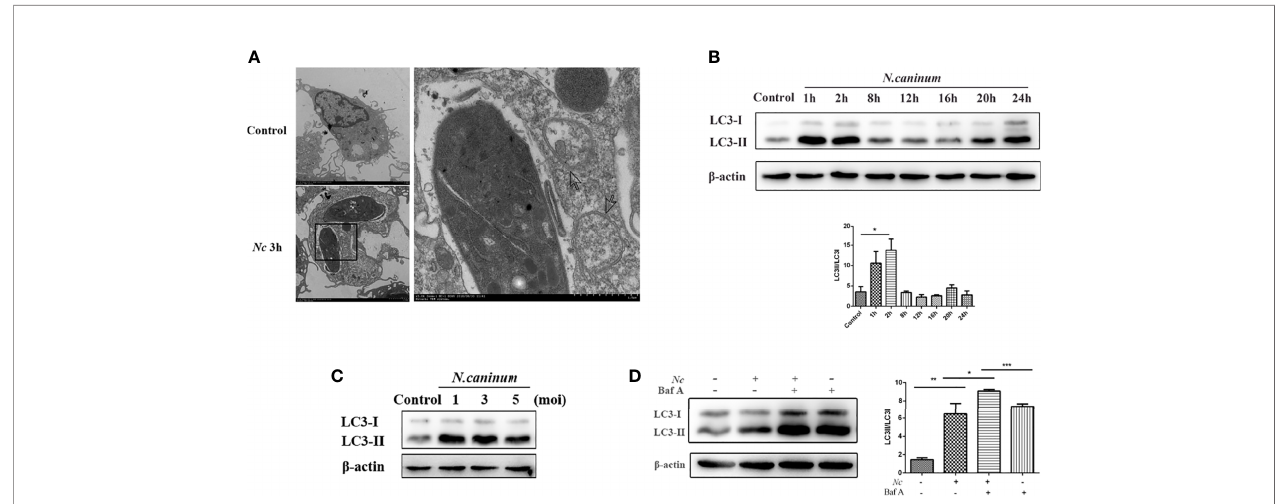
FIGURE 1 | Autophagosomes accumulate in Neospora caninum -infected macrophages. (A) Representative transmission electron microscopy images of the control and Nc -infected mouse macrophages at 3 h postinfection. Arrows indicate representative autophagosomes. (B) Peritoneal macrophages were infected with N. caninum tachyzoites (MOI = 3), and total protein was extracted after 0, 1, 2, 4, 8, 12, 16, 20, and 24 h. The expression of LC3 and the ratio of LC3-II to LC3-I were examined at the indicated times. (C) Infection at different N. caninum infection ratios (MOI = 1, 3, 5) with macrophages for 2 h. Upregulated LC3 expression was observed in each group. (D) Peritoneal macrophages were pretreated with or without ba fi lomycin A1 (Baf A1; 100 nM) for 4 h prior to infection with N. caninum tachyzoites (MOI = 3), and the expression of LC3 was determined 2 h later. * P < 0.05, ** P < 0.01, *** P < 0.001 compared with the control groups. The data shown are representative of three independent